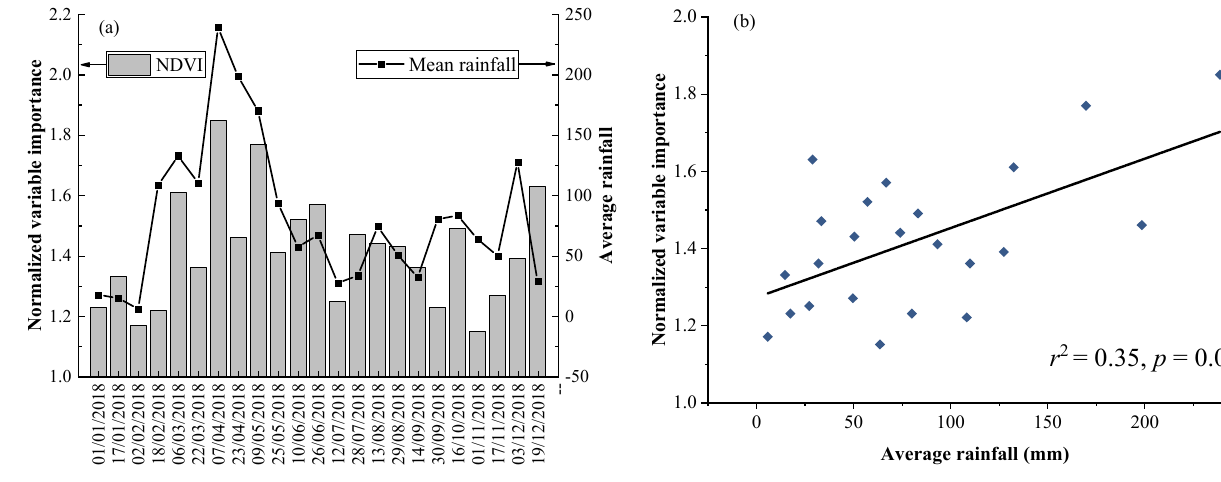
Figure 9. ( a ) Normalized variable importance of NDVI and 16-day cumulative mean rainfall data in the high-rainfall area and ( b ) the linear relationship between them.